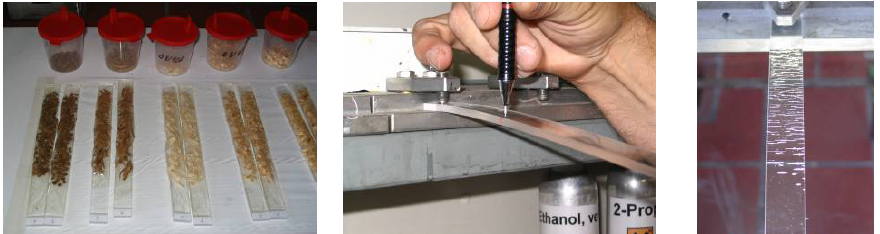
Figure 6a, b and c: Environmental stress cracking tests with wood PMMA